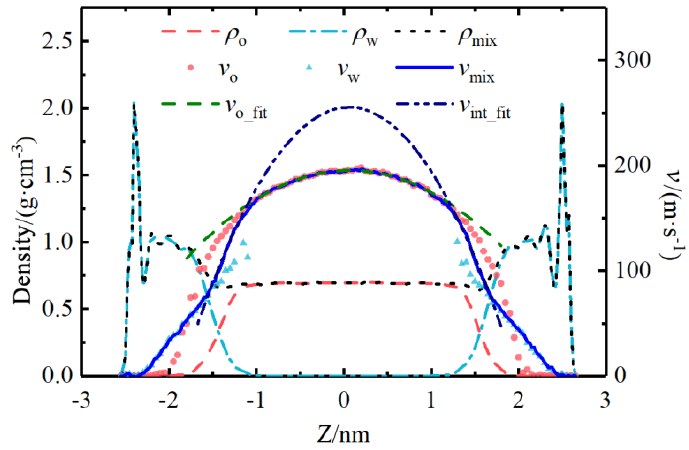
Figure 5. Density and velocity distribution of oil − water two-phase fluid in quartz nanopores.